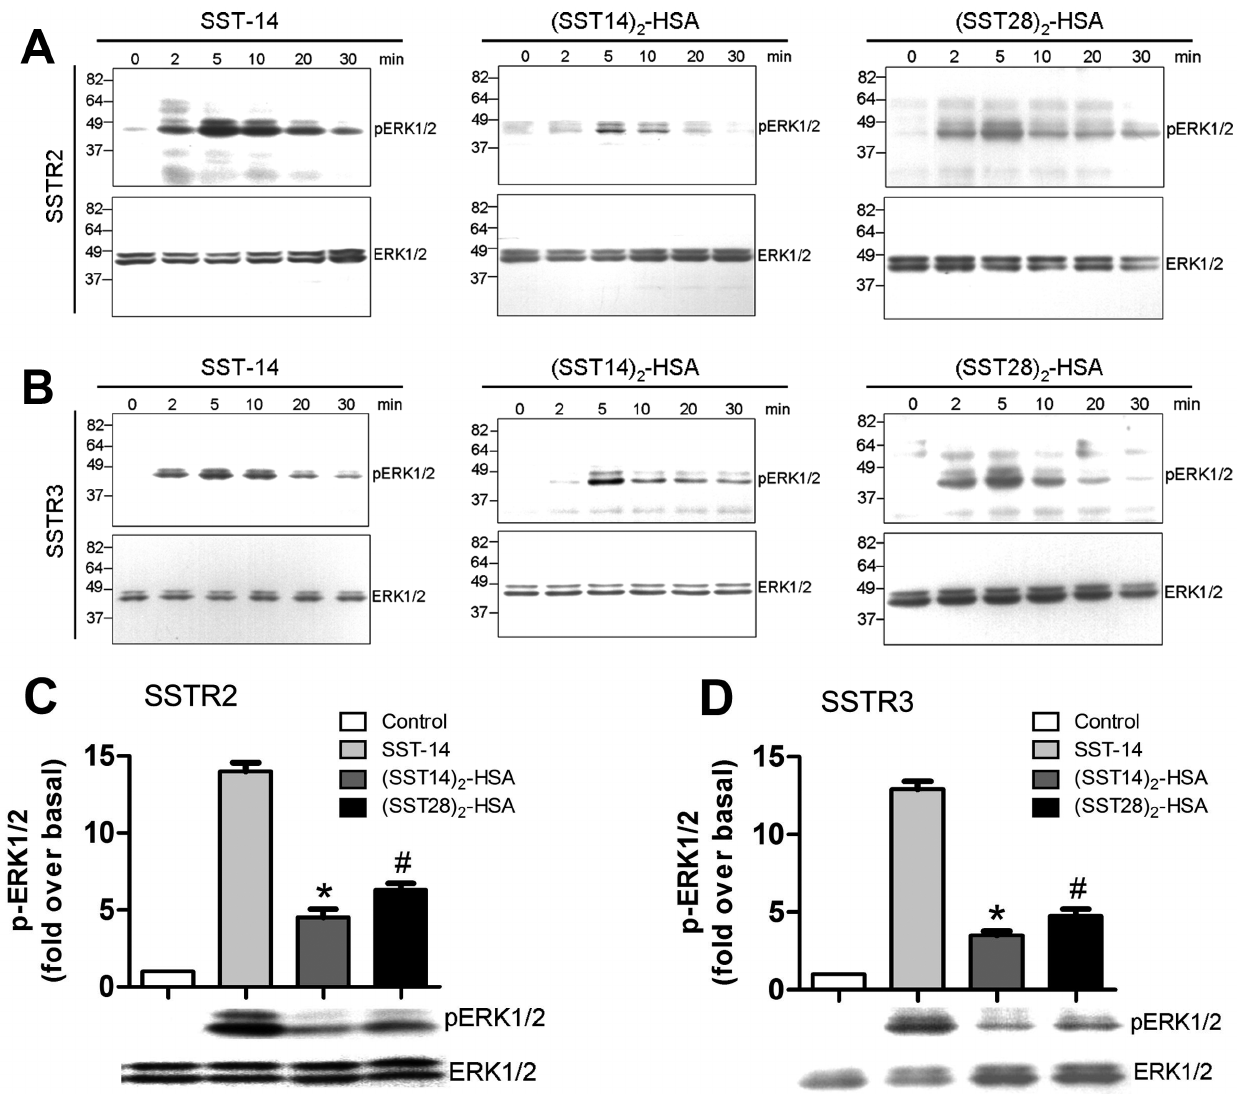
Figure 4. Comparison of SST-14-, (SST14) 2 -HSA- and (SST28) 2 -HSA-induced ERK activation in SSTR2- and SSTR3-expressing cells. (A, B) Time-dependent ERK1/2 activation. HEK 293 cells expressing SSTR2 or SSTR3 were exposed to 1 m M SST-14, (SST14) 2 -HSA, or (SST28) 2 -HSA for 0, 2, 5, 10, 20, or 30 minutes. Cells were lysed, equal amounts of protein were resolved by SDS-PAGE, and levels of total ERK1/2 and phosphorylated ERK1/2 were determined by immunoblotting. Two additional experiments gave similar results. (C, D) Agonist-induced ERK1/2 activation. HEK 293 cells expressing SSTR2 or SSTR3 were exposed to 1 m M SST-14, (SST14) 2 -HSA or (SST28) 2 -HSA for 5 minutes. The cells were lysed, equal amounts of protein were resolved by SDS-PAGE, and the levels of total ERK1/2 and phosphorylated ERK1/2 were determined by immunoblotting. Results were quantified by densitometric analysis. The data were normalized to total ERK1/2 and expressed as the fold ERK1/2 phosphorylation over the basal value in untreated cells. The values represent the means 6 S.E. of three independent experiments performed in duplicate. *, p , 0.01, (SST14) 2 -HSA-treated cells compared with SST-14-treated cells. # , p , 0.01, (SST28) 2 -HSA-treated cells compared with SST-14-treated cells.